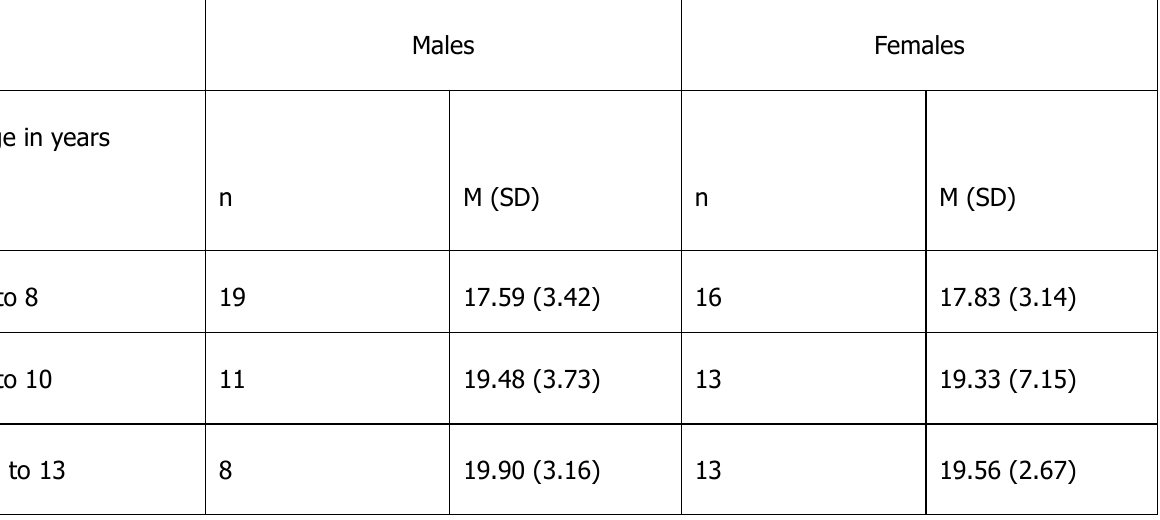
Body Mass Index Scores by Age and Gender: Means and Standard Deviations Males